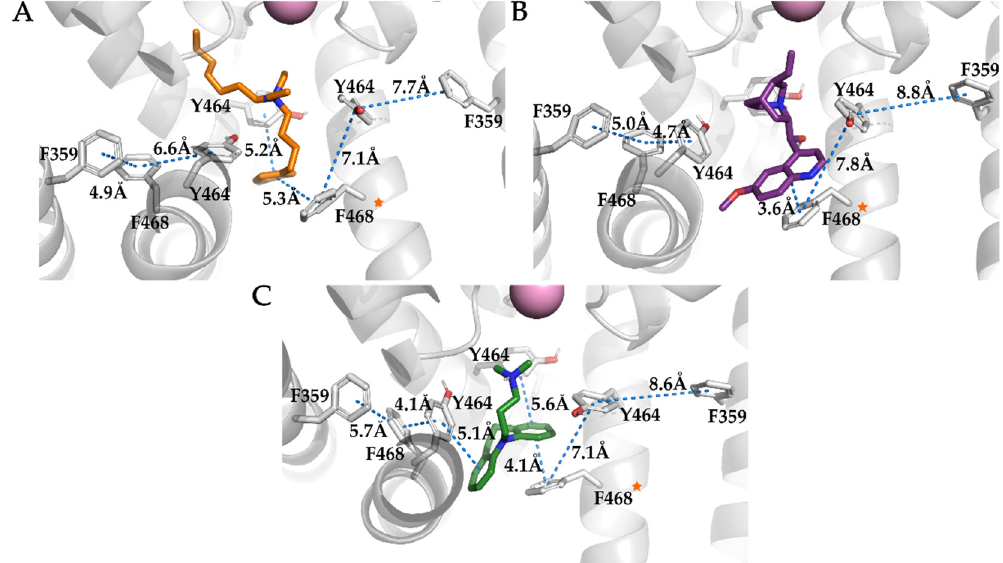
Figure 9. Rotation of the F468 side chain (orange star) upon ligand binding within the homology model of the K V 10.1. The distances measured between the aromatic network formed with residues F359, Y464, F468, and the ligands are shown with blue dashed lines. Uncoupling between F359 and Y464 of the subunit with rotated F468 shows ~2–3 Å increase in distance between the aromatic rings. One subunit is hidden to increase the visibility of the interactions. ( A ) Clofilium (orange sticks) forms T-shaped and parallel-displaced π – π interactions. ( B ) Imipramine (green sticks) forms two T-shaped and one parallel-displaced π – π interaction. ( C ) Quinidine (purple sticks) forms a parallel-displaced π – π interaction.